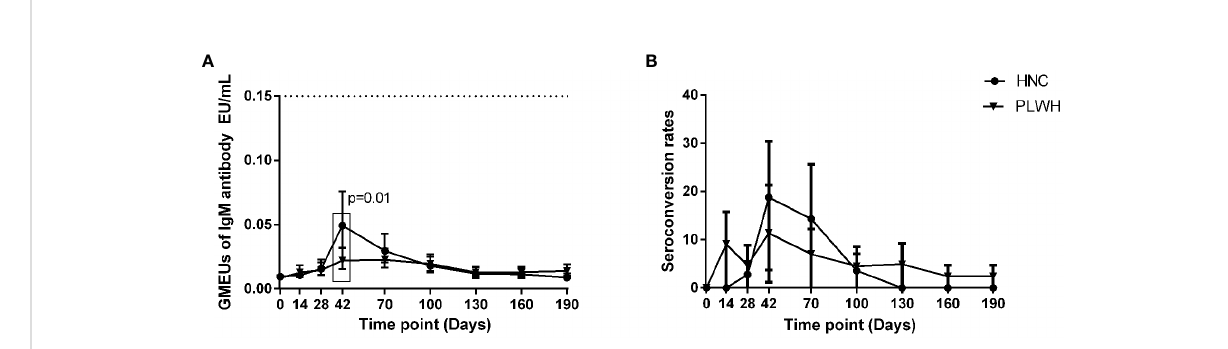
FIGURE 2 IgM antibody responses to vaccination with inactivated COVID-19 vaccine in PLWH and HNC. Titers (A) and seroconversion rates (B) of IgM at days 0-190 after vaccination. The threshold for a positive response is shown by the hashed line at 0.15 EU/mL. Data points are medians (error bars represent 95% CI). P value calculated using Mann – Whitney U test (A) or Fisher ’ s exact test (B) .